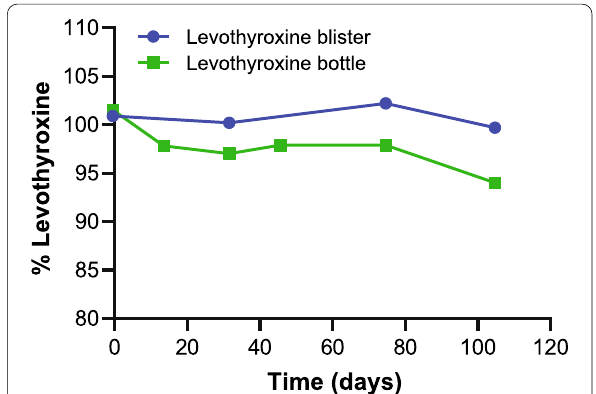
Fig. 4 Potency of levothyroxine tablets in blister packs and bottles over time